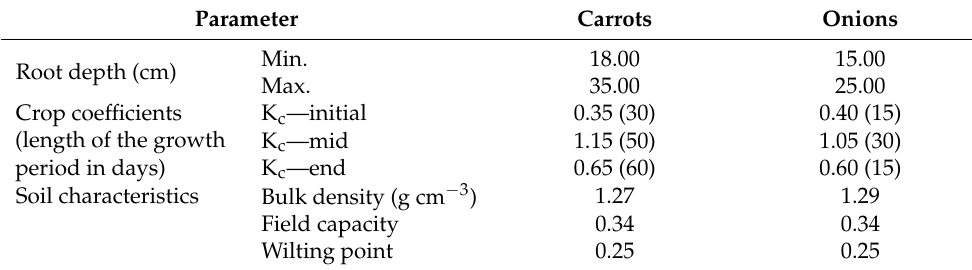
Table 1. Soil and crop data used for the execution of the CROPWAT model.